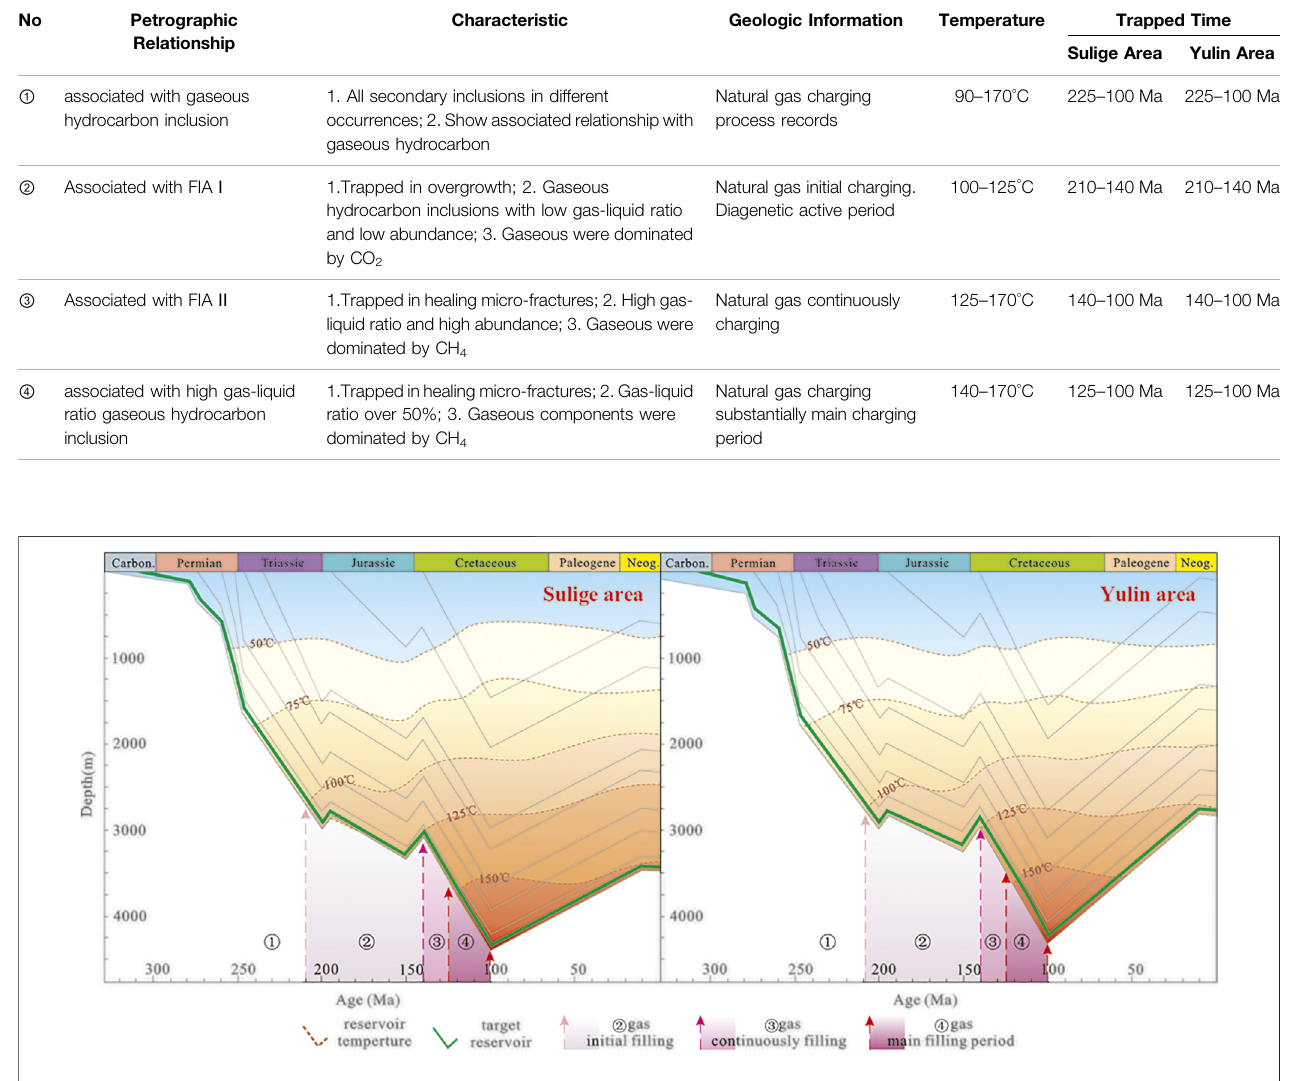
FIGURE 6 | The gas accumulation period based on the thermal history of Upper Paleozoic in Ordos Basin.